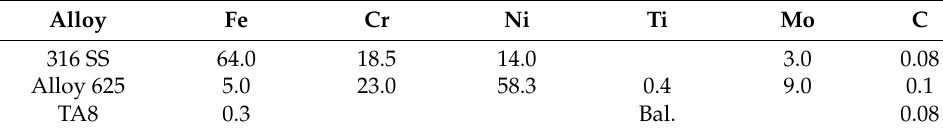
Table 1. Main chemical compositions of the tested alloy (in wt.%).